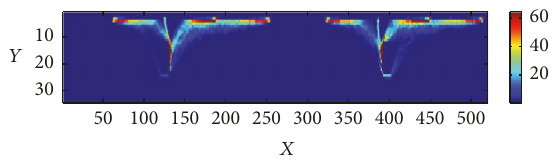
Figure 7: CD 𝑖,𝑗 during the boarding process.